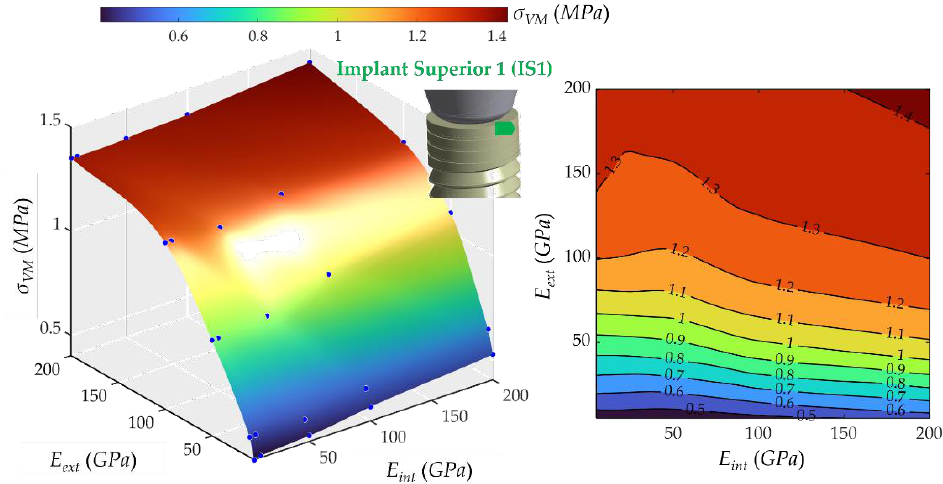
Figure 9. Von Mises maximum stress at the first upper part of the implant, implant superior 1 (IS1). ( Left ): 3D representation. ( Right ): vertical projection.